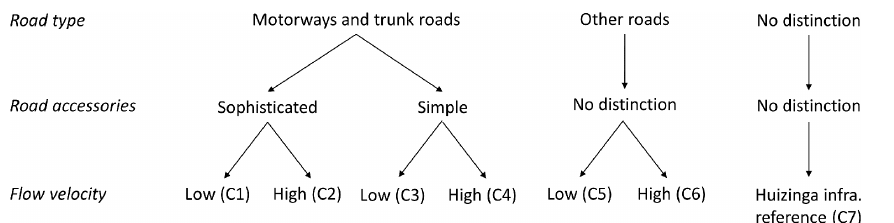
Figure 3. Dimensions used for differentiating the new damage curves (C1–C6) and the Huizinga infrastructure reference curve